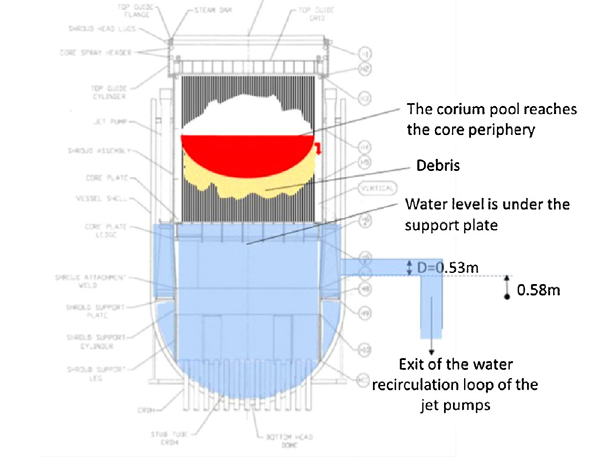
Fig. 3. Illustration of the corium fl ow in the core annulus pool: ∼ 5 h 40 after the reactor shutdown.